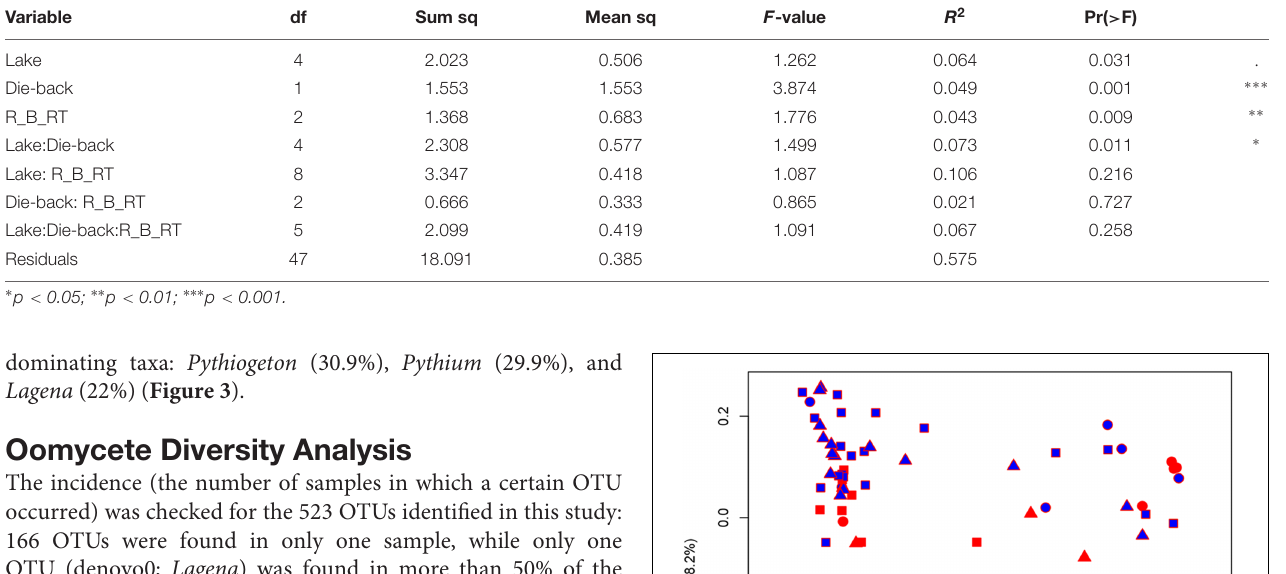
TABLE 1 | Results from permutational multivariate analysis of variance to partition the variance in oomycete communities for the combined data. R_B_RT indicates the compartment: R, rhizosphere; B, bulk soil; RT, roots. Variable df Sum sq Mean sq